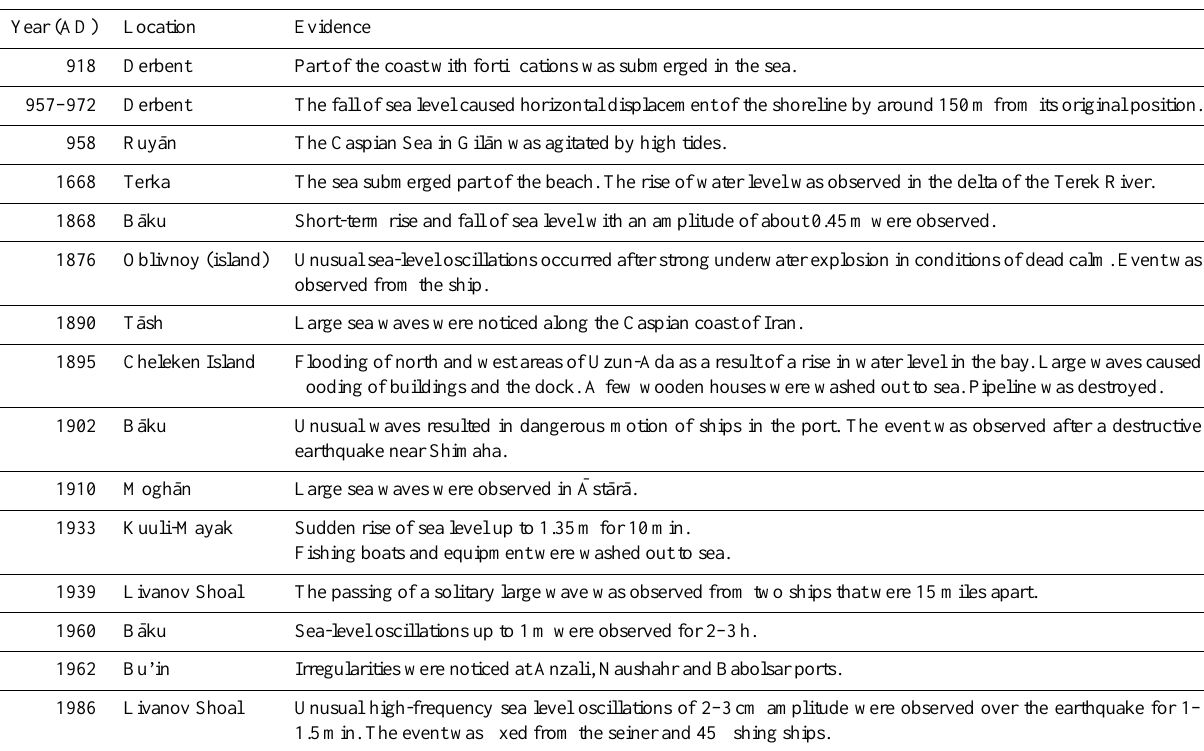
Table 6. Historical earthquakes in the Caspian Sea region and the observed consequences on the sea level (Modified after Dotsenko et al.,